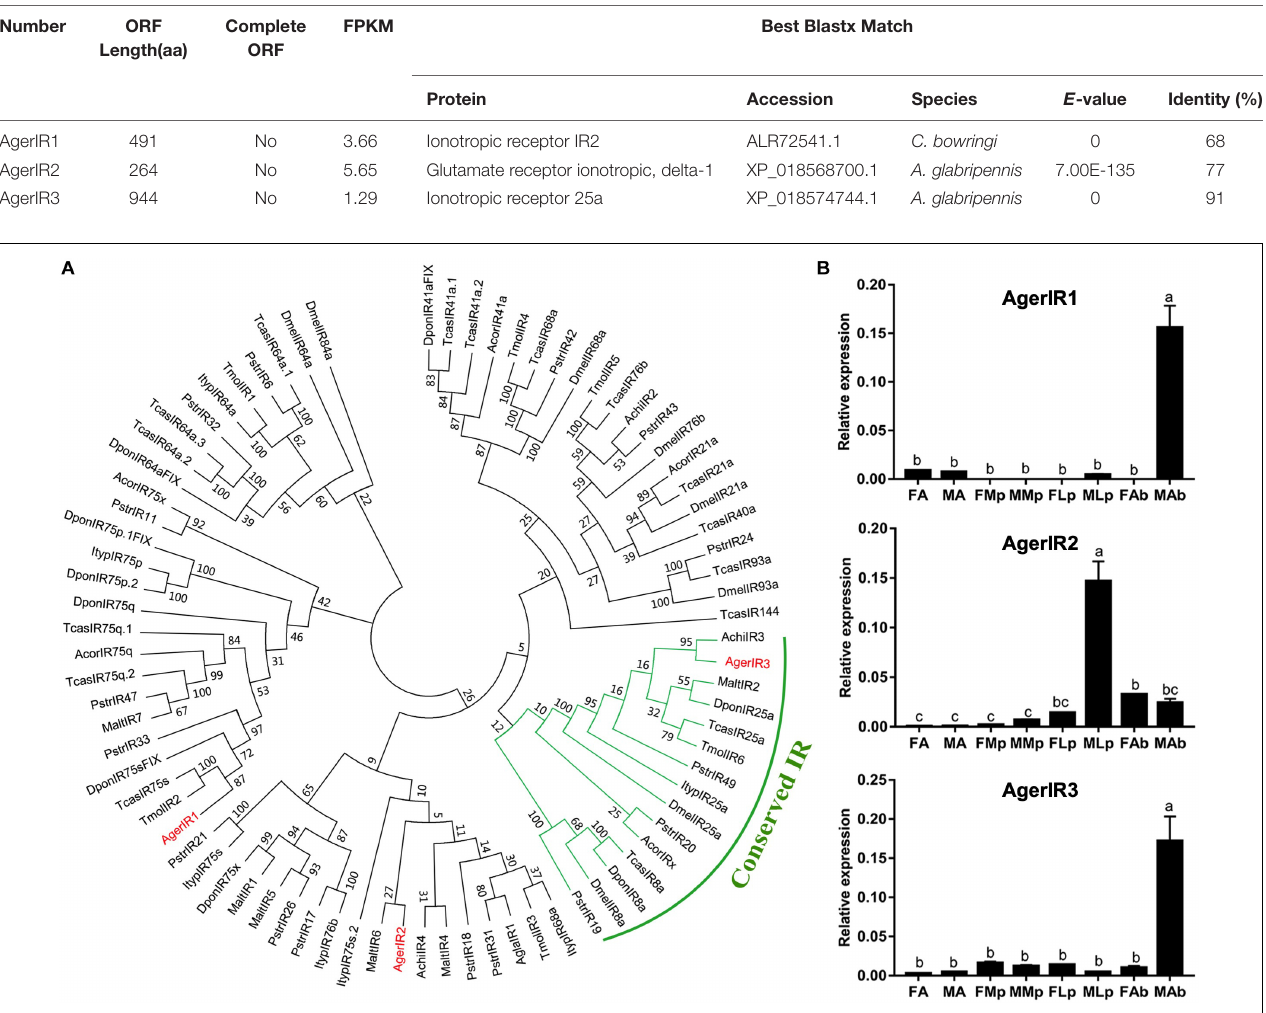
TABLE 3 | Blastx match of A. germari IR genes.